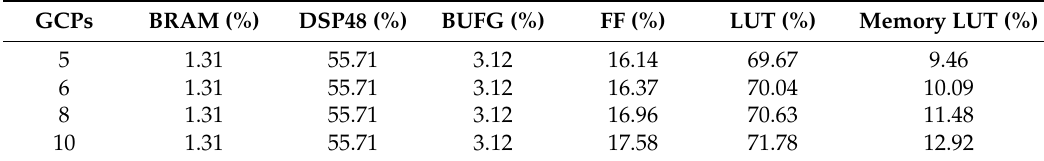
Table 6. The utilizations of FPGA resources under different numbers of